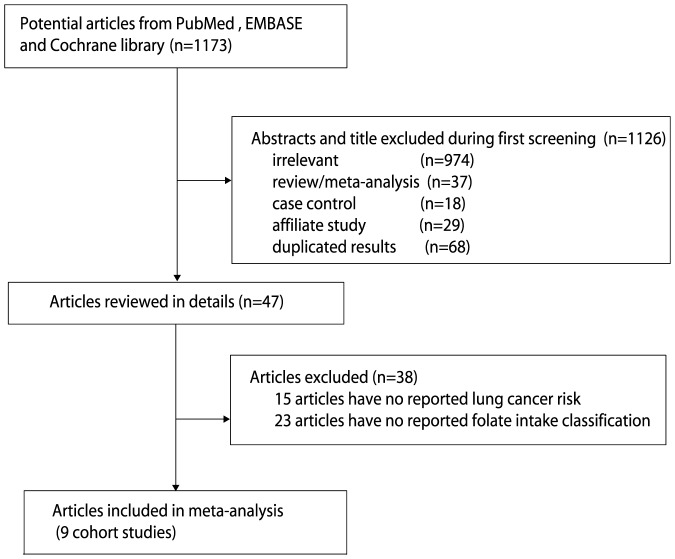
Flow diagram of the literature search and studies selection process.